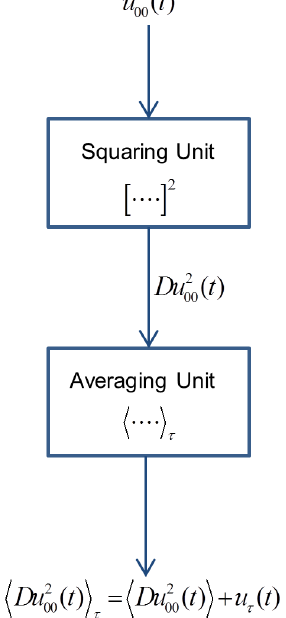
Figure 3. Illustration of the measurement process at 00. D is calibration coefficient of the squaring device to provide a Volt unit with the correct numerical value for the squaring operation.